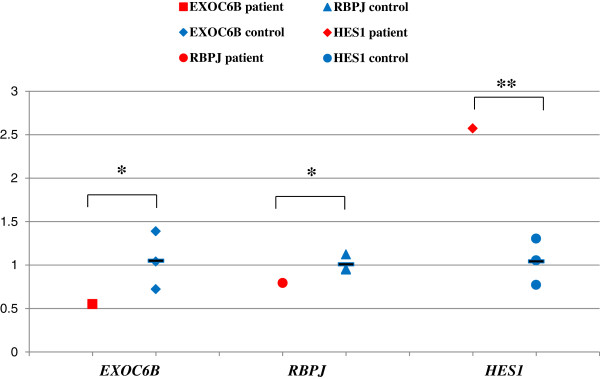
mRNA expression of EXOC6, RPJB and HES1 in whole blood of Subject 1 and controls. Values for EXOC6, RPJB and HES1 mRNA expression in whole blood were normalized to the corresponding ß-actin mRNA levels. The results derived from at least three sets of samples and the mean level of each sample is represented in the scatter graph, horizontal bar is an average value between three controls. The difference between subject 1 and the average of the controls has been evaluated by student t-test (*, p < 0.05; **, P < 0.01).